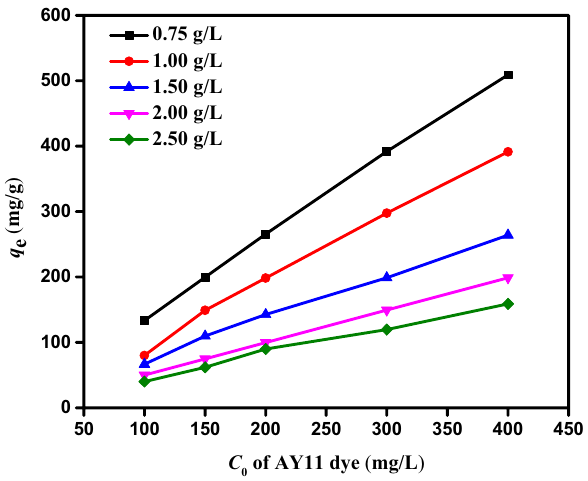
Figure 8. Impact of C 0 of AY11 dye (100–400 mg/L) by PPAC dosage (0.75–2.50 g/L) on q e (mg/g), and Temp. (25 °C).